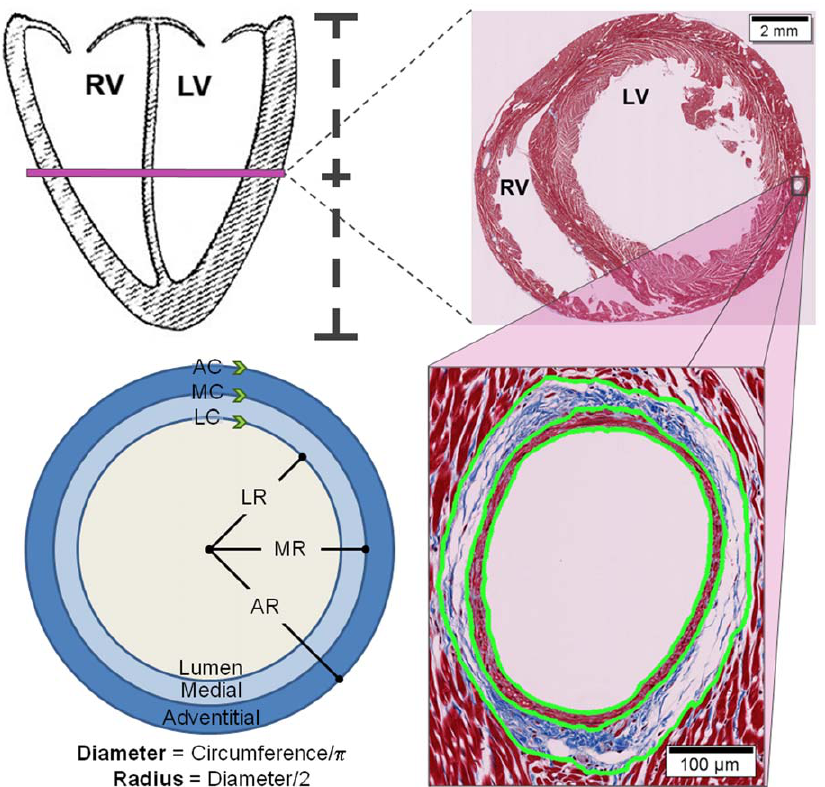
Figure 1. Acquisition of histological samples. Schematic representation that illustrates the location, selection, and analysis method of the histological specimens used to measure arteriolar wall thickness. Sectioned histologic specimens were obtained in a short axis plane located K the distance between the mitral annulus and the apex of the left ventricle (top left). In the top right panel, a low resolution image of the rat myocardium at 2x with high resolution is shown with an insert of a coronary arteriolar vessel at 20x (bottom right). Values for individual artery lumen, medial and adventitial circumferences (LC, MC, and AC, respectively) were obtained by tracing the region of interest using the digital imaging analysis program NDP.view (indicated in green, bottom right). The bottom left panel shows how the circumference data were used to find the lumen, medial, and adventitial radii (LR, MR, and AR, respectively) in order to calculate average diameters and wall thickness.